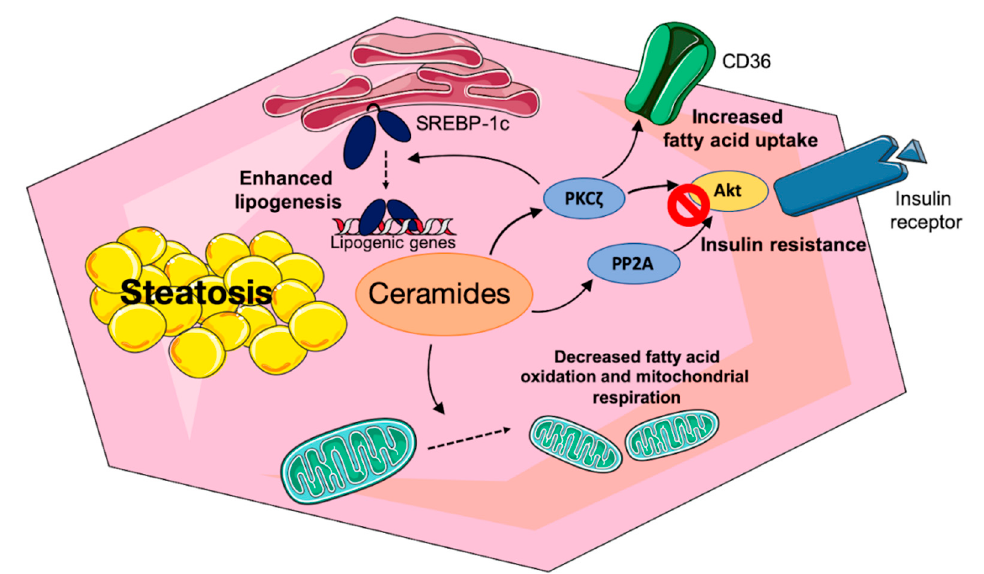
Figure 2. Actions of ceramides on hepatocyte lipid metabolism. Ceramides increase the availability of fatty acids for triglyceride synthesis by promoting the expression and transfer to the plasma membrane of the fatty acid transporter CD36, by inducing the cleavage of the precursor form of the transcription factor SREBP-1c which activates the expression of lipogenic genes, and by reducing fatty acid oxidation in mitochondria. Ceramides also induce hepatic insulin resistance by reducing the insulin-dependent activation of the protein kinase Akt, thus contributing to dysfunctional glucose